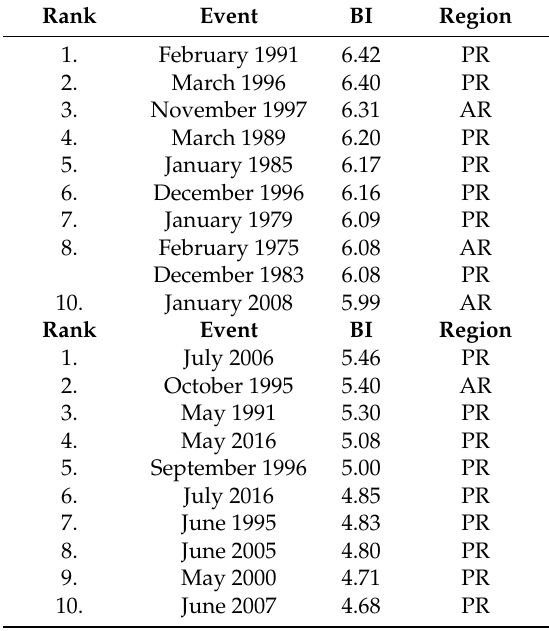
Table A6. The top 10 strongest (BI) blocking events in the Northern Hemisphere (top) and Southern Hemisphere (bottom) from 1968 to the